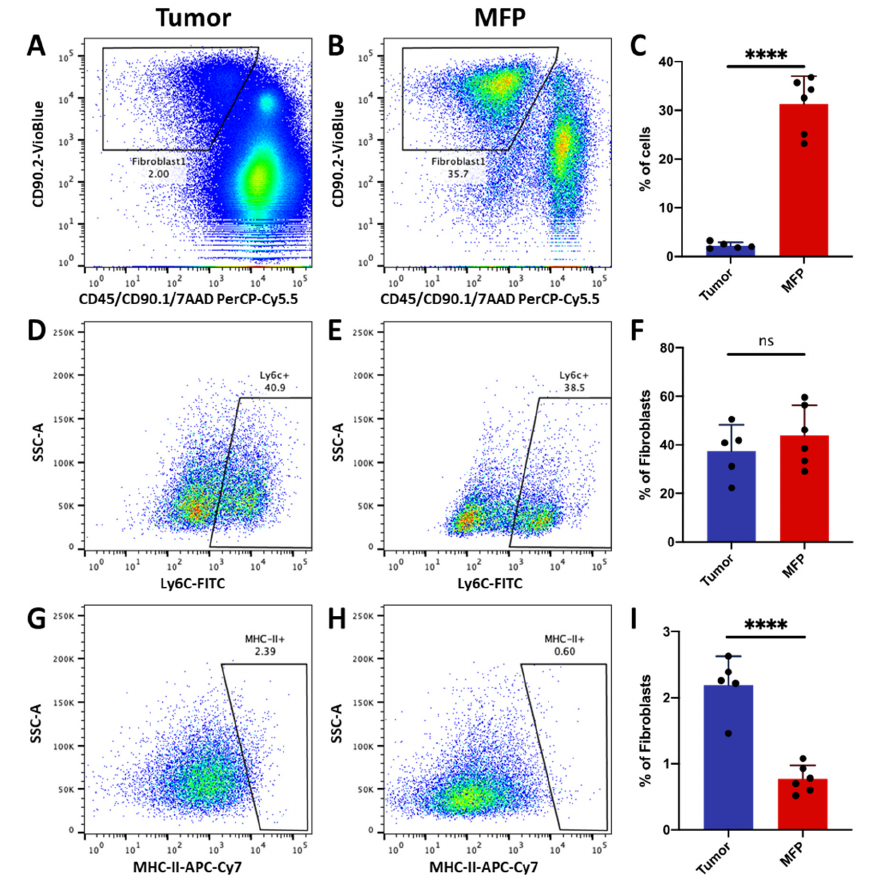
Figure 6. Inflammatory fibroblasts and MHC class II-expressing fibroblasts in mammary tumors and naïve mammary fat pad. Flow cytometry plots identifying viable (7AAD − ) CD90.2+/CD90.1 − /CD45 − fibroblasts derived from ( A ) tumor or ( B ) naïve mammary fat pad (MFP). ( C ) Bar graph of Thy1 + fibroblastabundanceintumorandMFP.FlowcytometryplotsidentifyingLy6c1 high